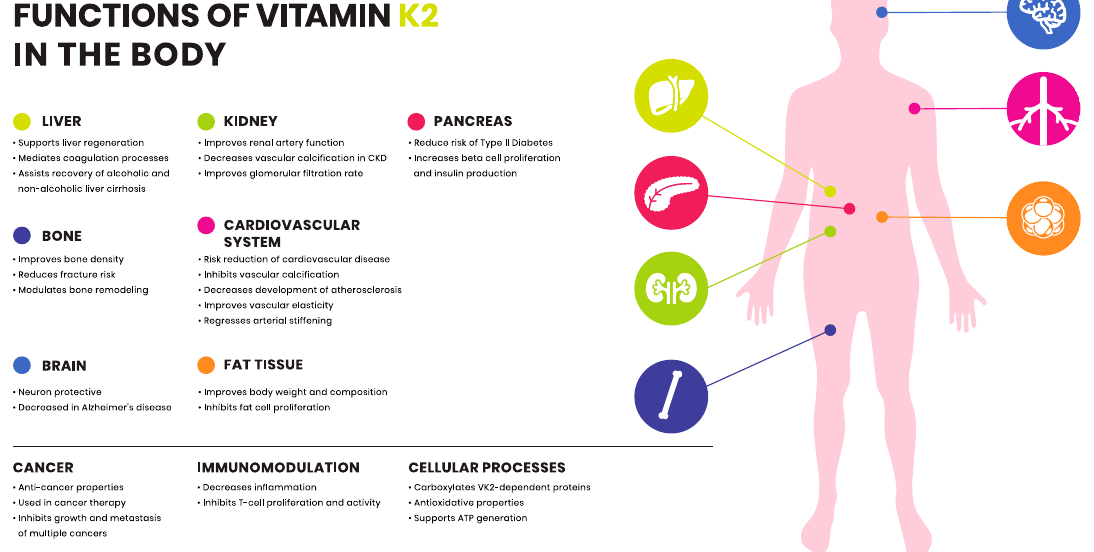
Figure 3. Functions of vitamin K2 in the body. Vitamin K2 exerts protective role and is involved in various organ systems throughout the human body (summarized in the figure).